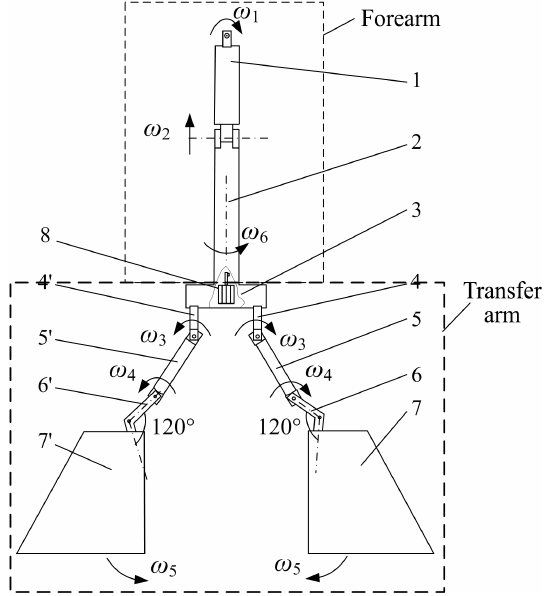
Figure 3. Winding robot forearm and transfer arm structure dia- gram. (1) Forearm connecting rod A, (2–3) middle rod, (4) forearm connecting rod B, (5) transfer arm connecting rod, (6) middle rod, (7) stopper and (8)